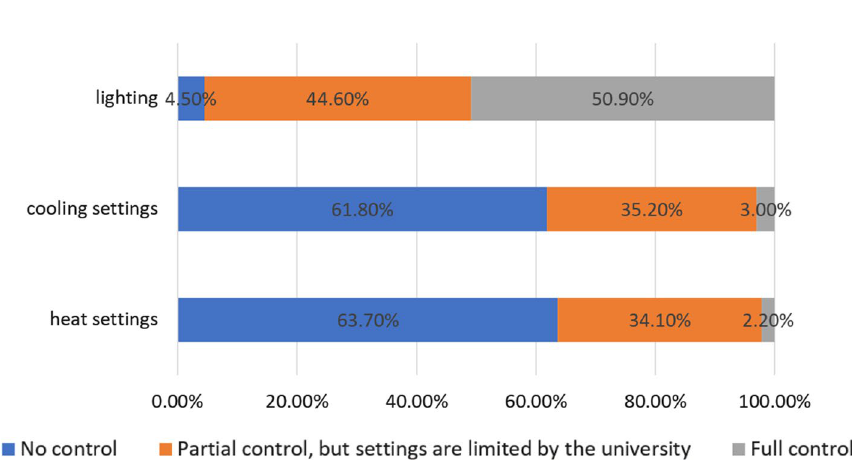
Fig. 9 Students’ opinions on indoor climate control in